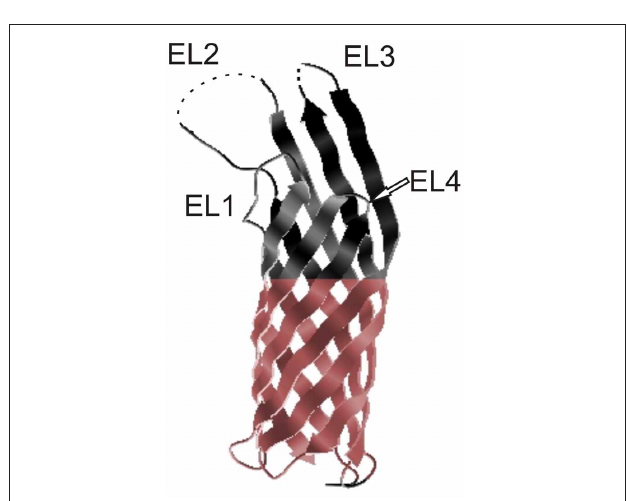
FIGURE 2 | Crystal structure of Ail. Extracellular loops are indicated EL1, EL2, EL3, and EL4 and the hydrophobicbelt is indicated in color. The tips of EL2 and EL3 are disordered and these regions are marked with dotted lines (Yamashita et al., 2011). The figure was generated from the PDBe Protein Data Bank in